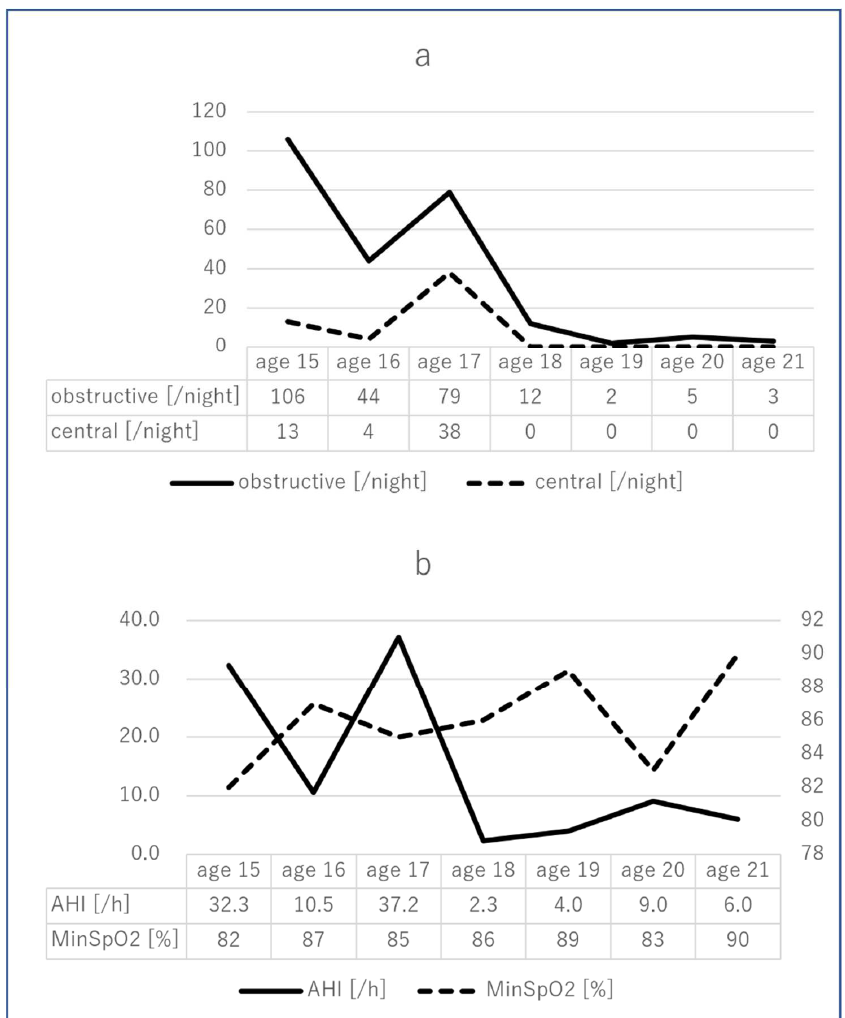
Figure 3. Time course of changes in the polysomnography examination. ( a ): The total number of obstructive and central sleep apnea events during sleeping at night. ( b ): Apnea–hypopnea index (AHI) score and minimum oxygen saturation (SpO 2 ) during sleeping at night.